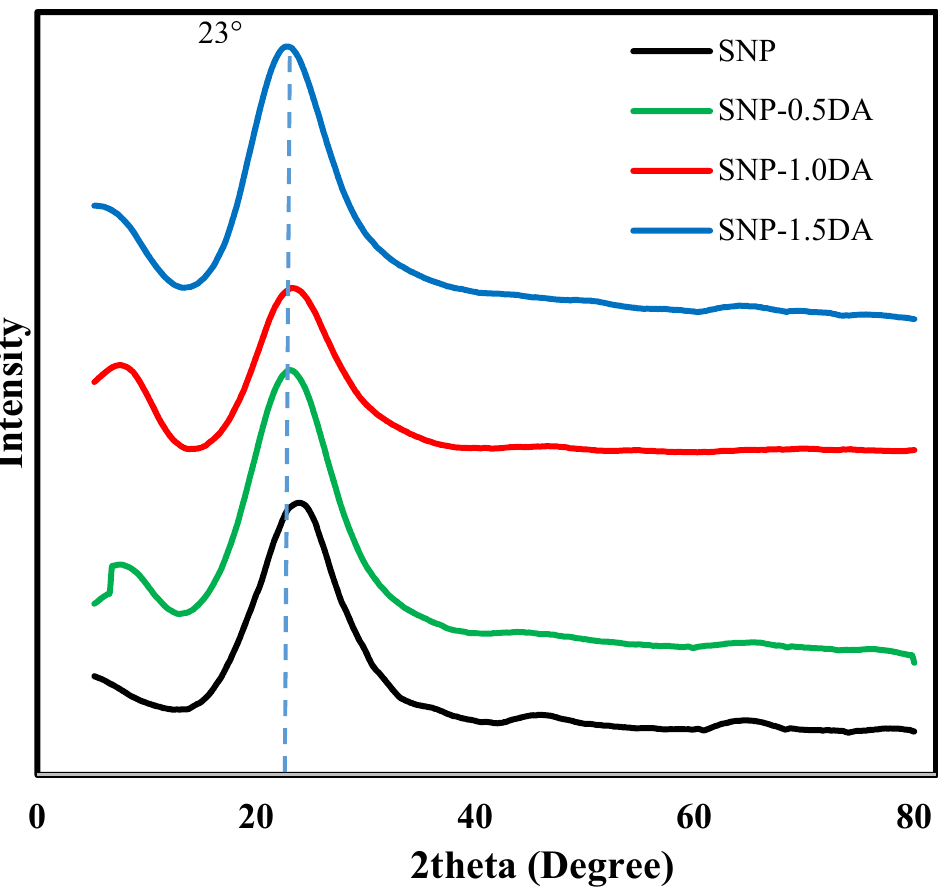
Figure 1. XRD spectra for the four nanocomposites over the 2 θ range of 5–80°.